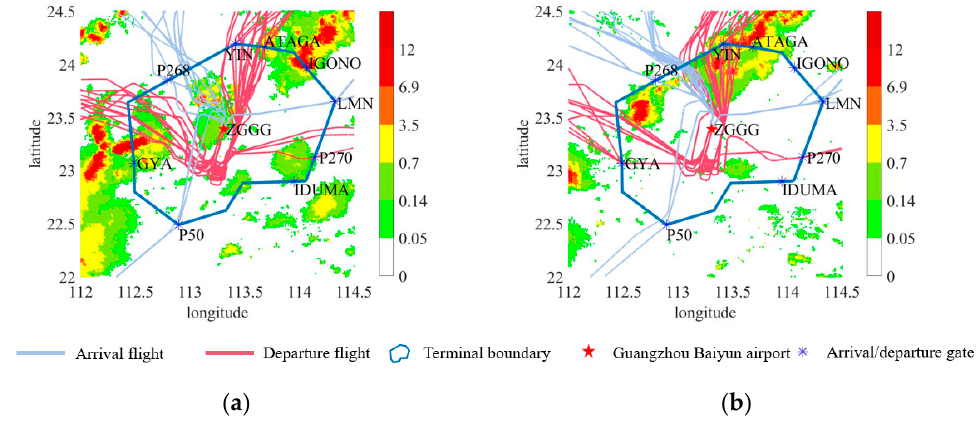
Figure 11. Overlay graph of radar tracks and weather information in Guangzhou terminal area. ( a )